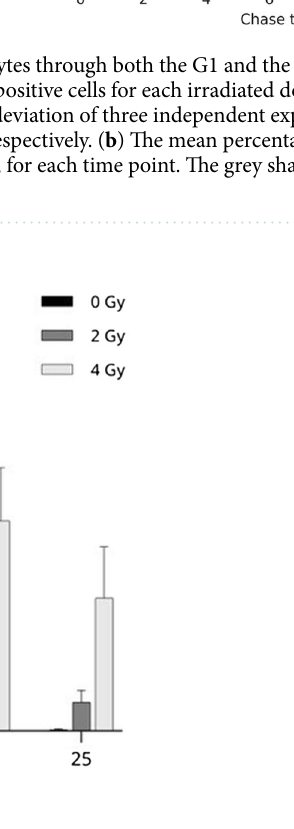
Figure 6. G2 arrest of EdU-labeled T lymphocytes after exposure to X-ray irradiation over time. The bar plots show the mean percentage of EdU-positive cells still residing in G2 arrest for non-irradiated and irradiated conditions, over multiple time points. Error bars show the standard deviation of the mean of three independent